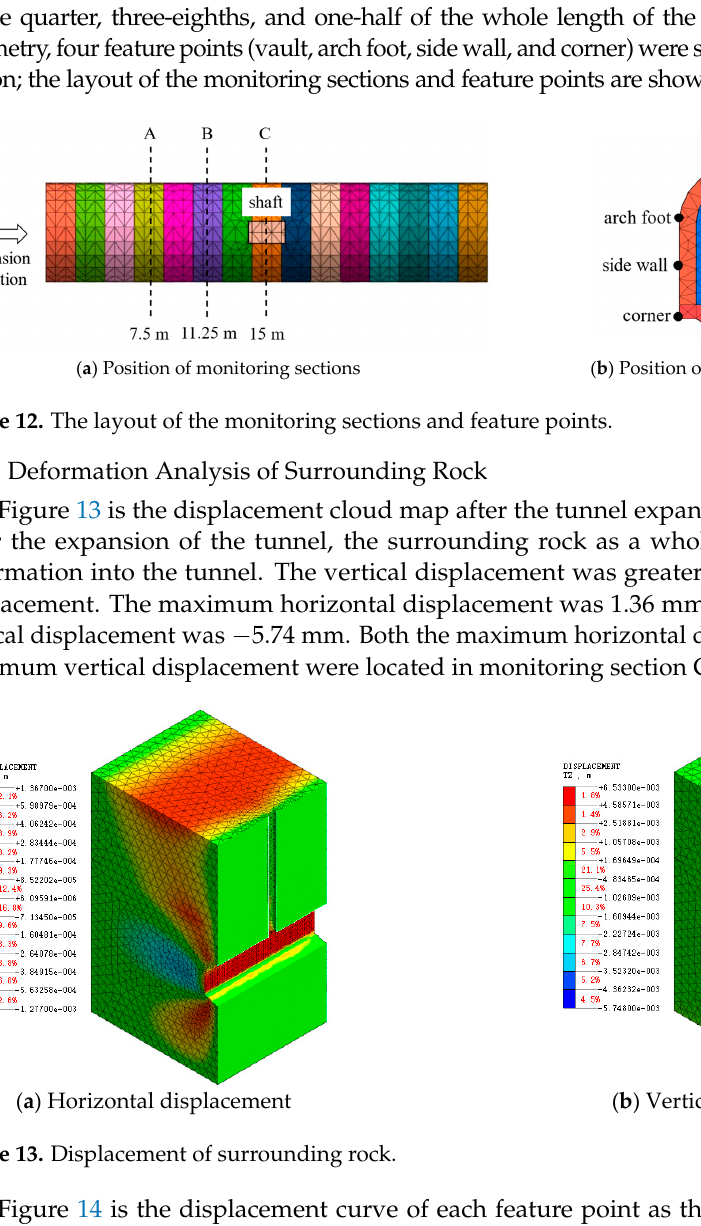
Figure 11. Stress comparison between monitoring value and calculation value.